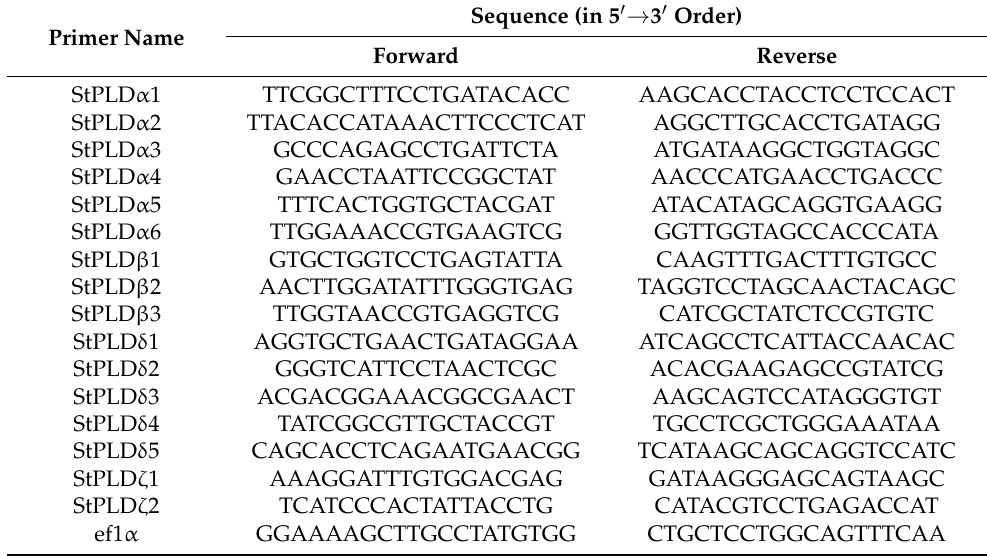
Table A1. The primer sequences used in qPCR